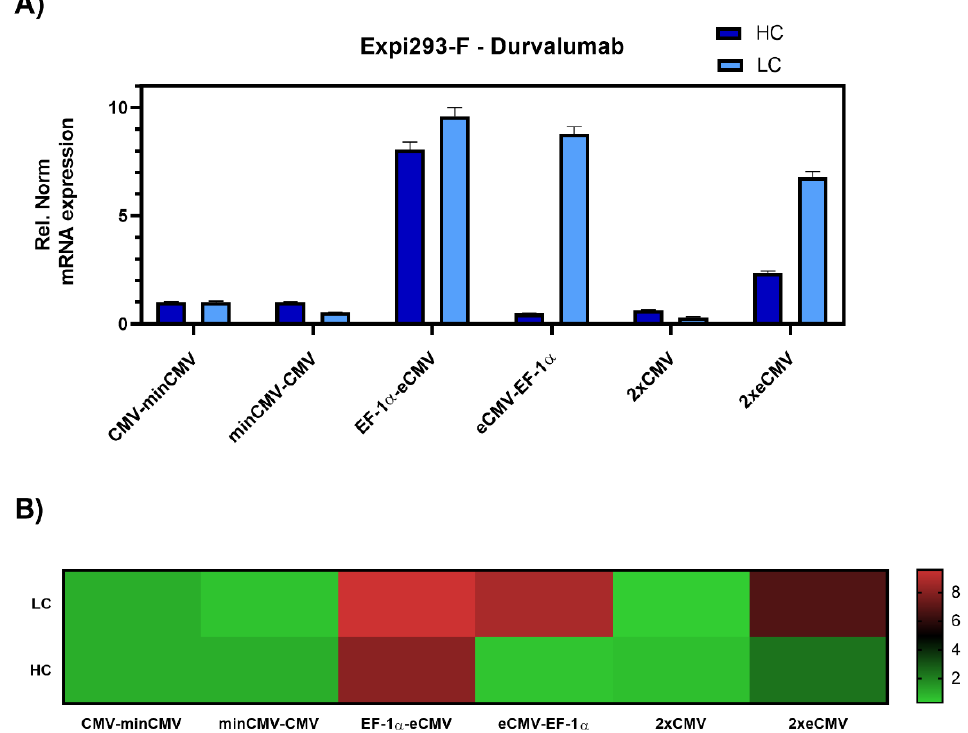
Figure 3. Gene expression analysis of heavy and light chain genes after transient transfection of Durvalumab in Expi293-F cells. ( A ) Bar chart representing heavy (dark blue) and light (light blue) chain mRNA expression in the different constructs. Values are relative to the CMV-minCMV construct and normalised to housekeeping genes GAPDH and RPLP0. Error bars represent the standard error of the mean of technical triplicates. ( B ) Heat map representation of gene expression analysis. The relative normalised gene expression for light and heavy chain mRNA is shown on the right.